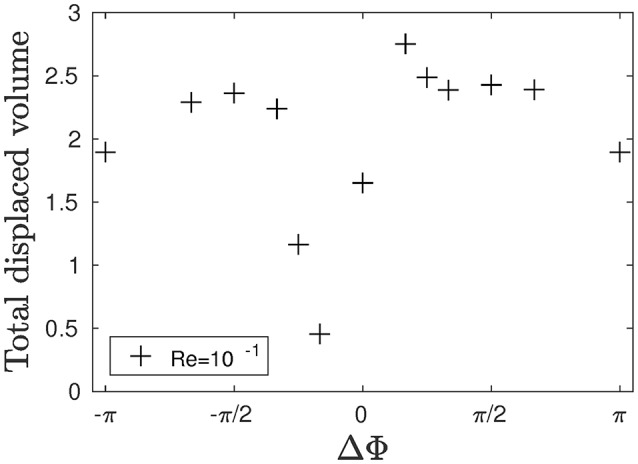
Total dimensionless displaced flow volume generated by an array of 24 × 2 cilia over a beating cycle for different phase lags ΔΦ and Re = 10−1.